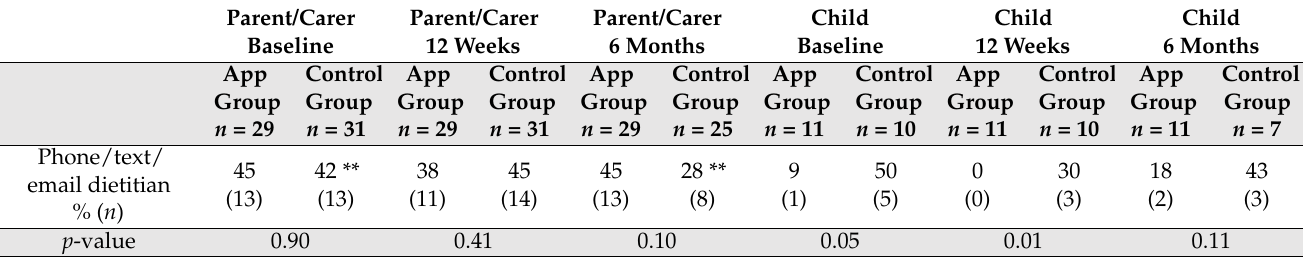
Table 4. Percentage of respondents accessing different sources of dietary information at least weekly at baseline, 12 weeks, and 6